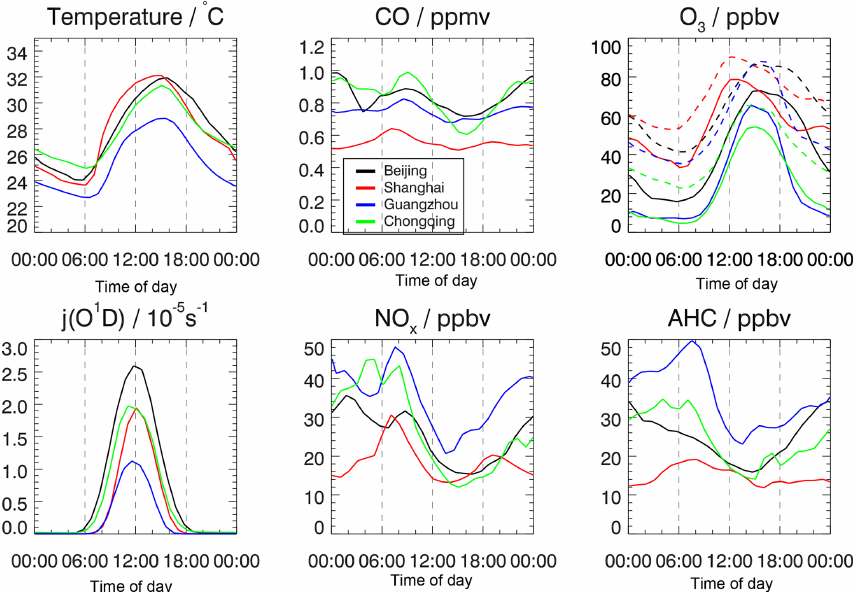
Figure 2. Mean diurnal variations of the measured temperature, CO, O 3 , j (O 1 D), NO x , and anthropogenic volatile organic compounds (AVOCs) concentration based on four field studies. The O x is denoted by dashed lines in the same panel as O 3 .